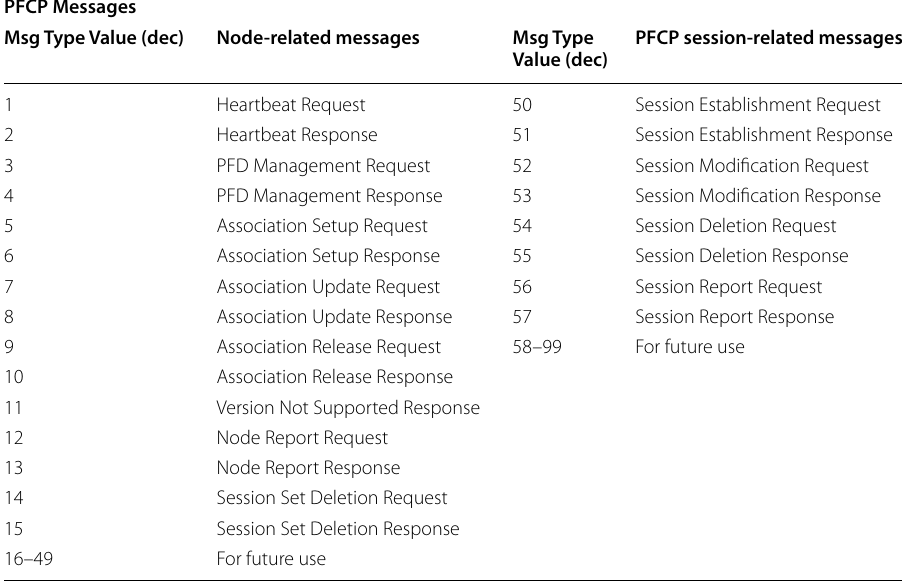
Table 2 PFCP Node and Session Messages PFCP